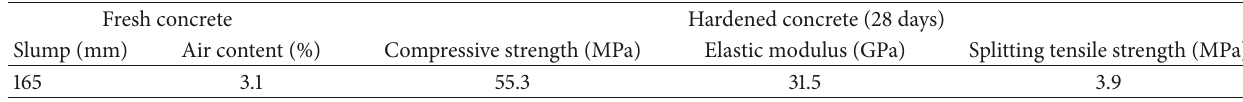
Table 2: Properties of AAS